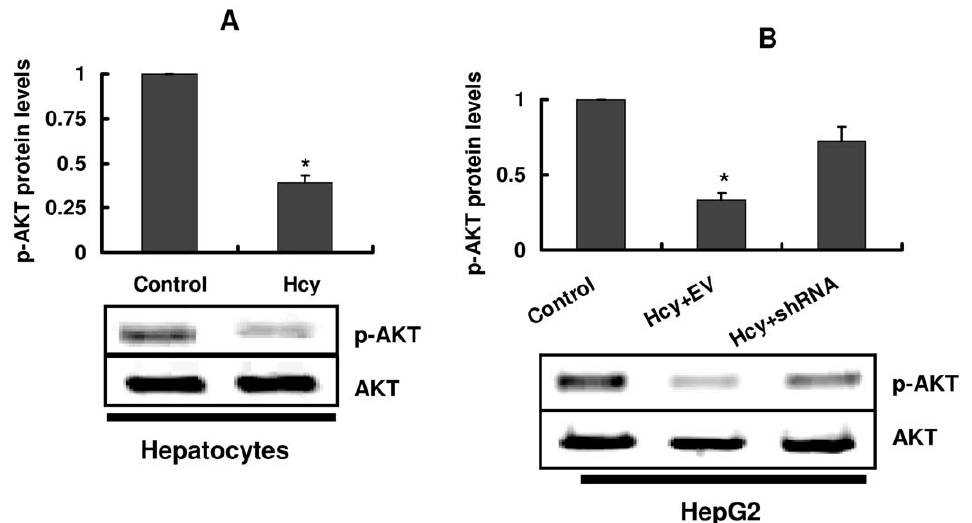
Figure 5. Homocysteine reduces phosphorylation of Akt. (A) Primary cultured hepatocytes were incubated with 1 mM homocysteine (Hcy) for 8 h. The protein levels were detected by Western blotting. The blot is typical of three experiments. The upper part shows quantification of immunoreactivity levels. The data are expressed as percent change from control. * P , 0.05 versus control (without Hcy). (B) HepG2 cells were transfected with shRNA against TRB3 mRNA. EV, empty vector. After incubated with 1 mM Hcy for 8 h, whole cell proteins were extracted and analyzed by Western blotting with antibodies against pSer-473-Akt. The blot is typical of three experiments. The upper part shows quantification of immunoreactivity levels. The data are expressed as percent change from control. * P , 0.05 versus control (without Hcy).